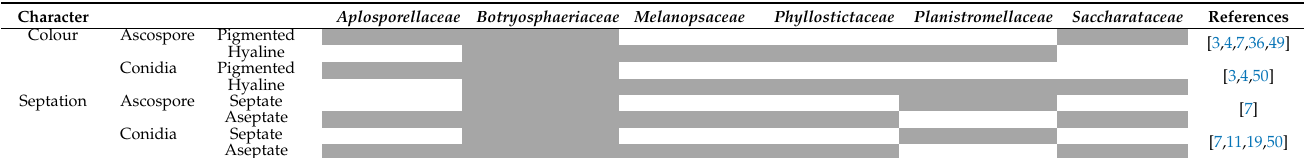
Table 1. Ascospore and conidial morphology (colour and septation) in Botryosphaeriales